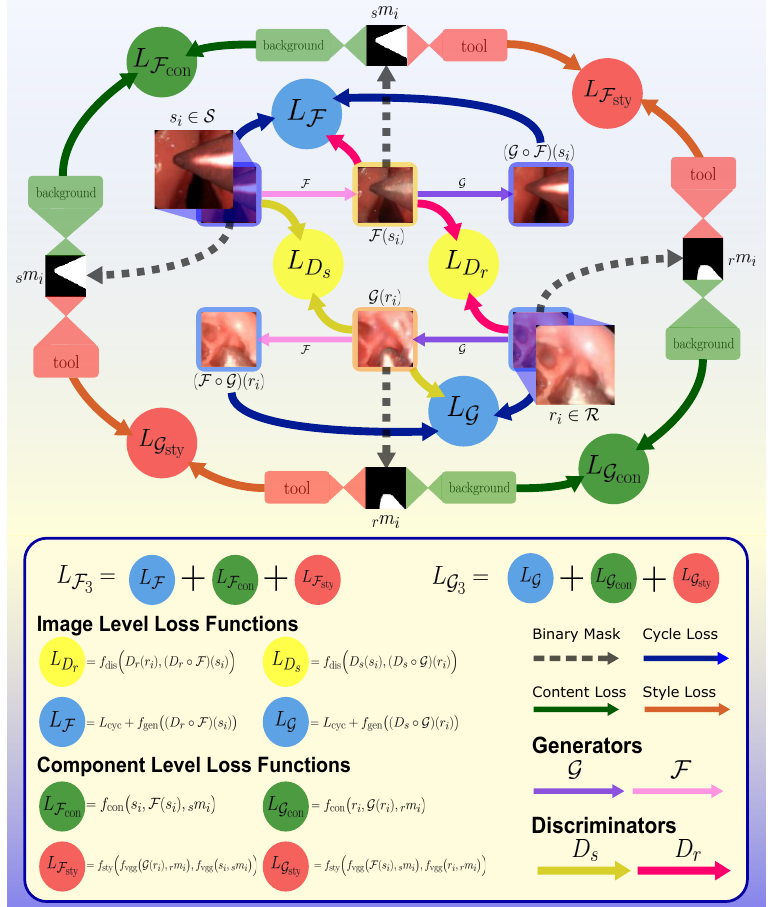
Figure 5. Flowchart diagram depicting Strategy III loss structure. L D the loss functions used for D r , D s , F , and G ,